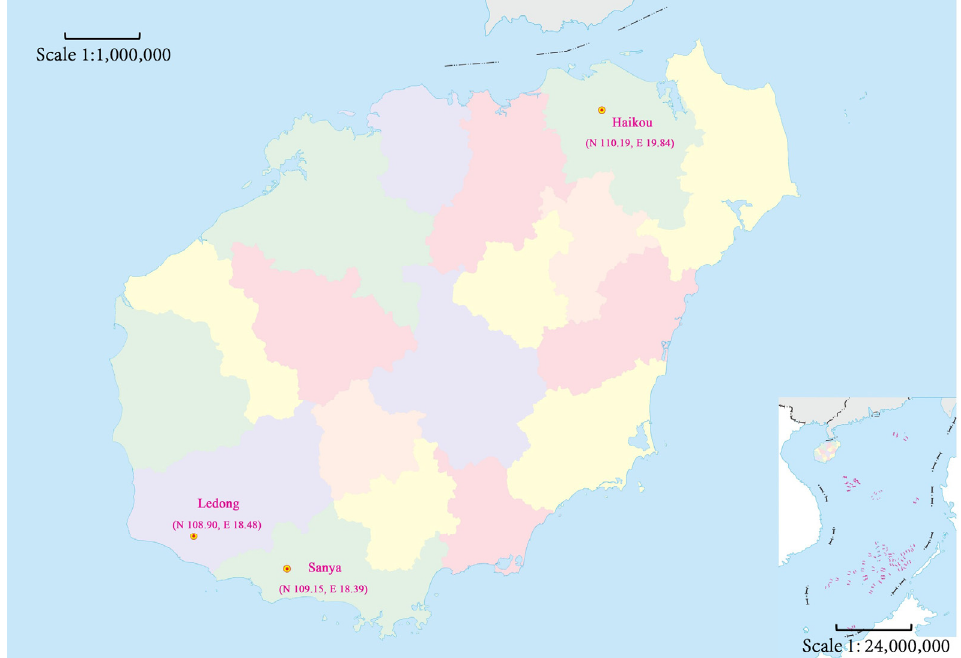
Figure 1. Map of Hainan Province showing the M. usitatus collection sites. (Supervised by Hainan Administration of Surveying Mapping and Geoinformation.) The scale of the main drawing is 1:1,000,000. In the lower-right corner is the South China Sea and the South China Sea Islands, with a scale of 1:24,000,000.